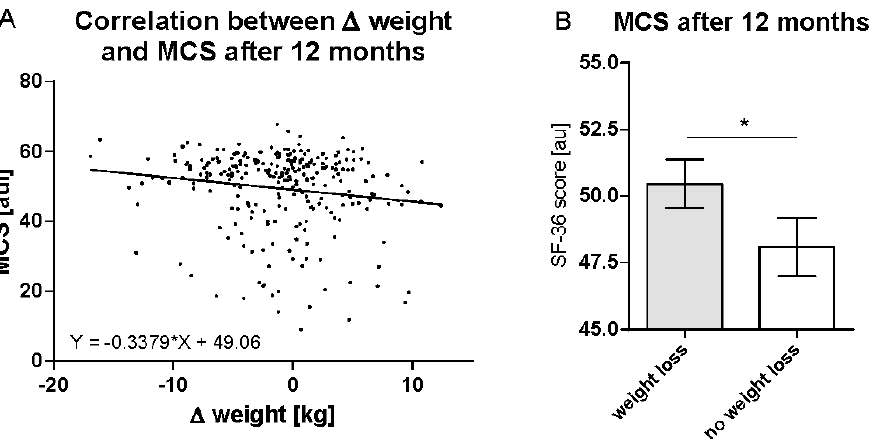
Figure 4. Weight loss accounts for MCS after 12 months. Shown is ( A ) the correlation between ∆ weight and mental component summary (MCS) after 12 months ( n = 263). Linear regression analysis was performed. ( B ) MCS after 12 months is shown after stratifying the cohort into two groups ( n = 147 vs. 116) according to weight loss. Differences were analysed using the Mann–Whitney test (*, p < 0.05). au, arbitrary